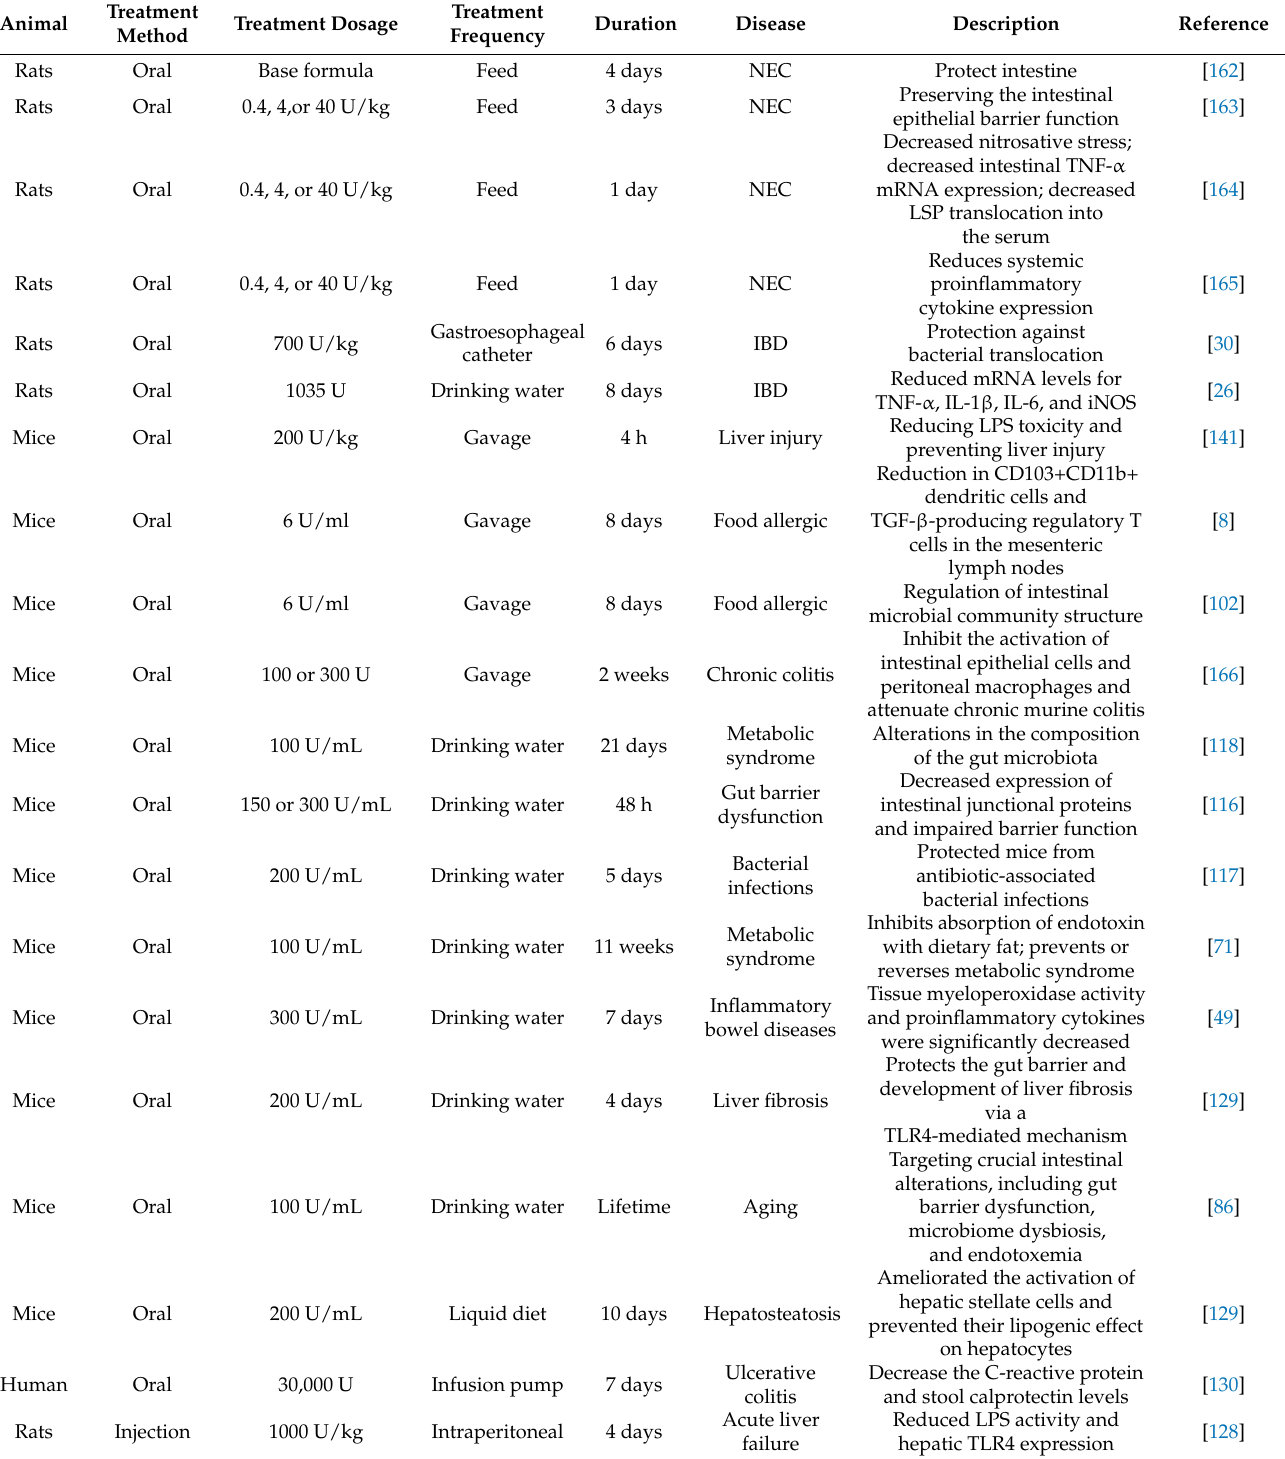
Table 1. Preventive and therapeutic effects of alkaline phosphatase (ALP) on diseases.